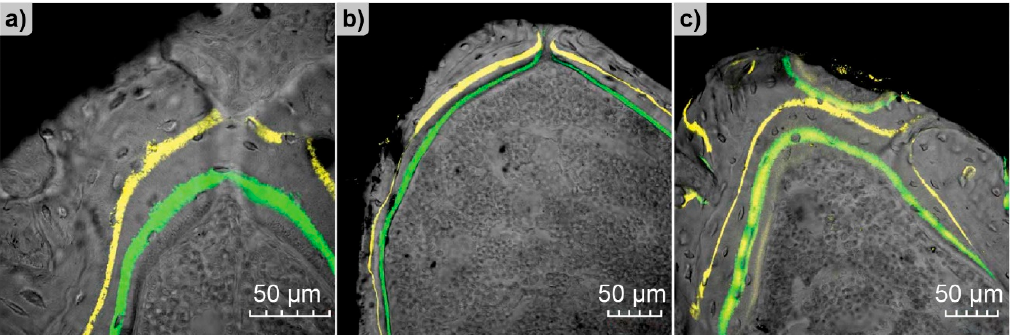
Figure 19. Laser scanning confocal microscopy images of bone remodeling after different types of implantation procedures: ( a ) sham surgery, ( b ) ovariectomy, and ( c ) strontium coated implant insertion. Labeling performed with tetracycline hydrochloride and calcein. Registered 4 weeks post-implantation, x400 magnification. Figure adapted with permission from [112].